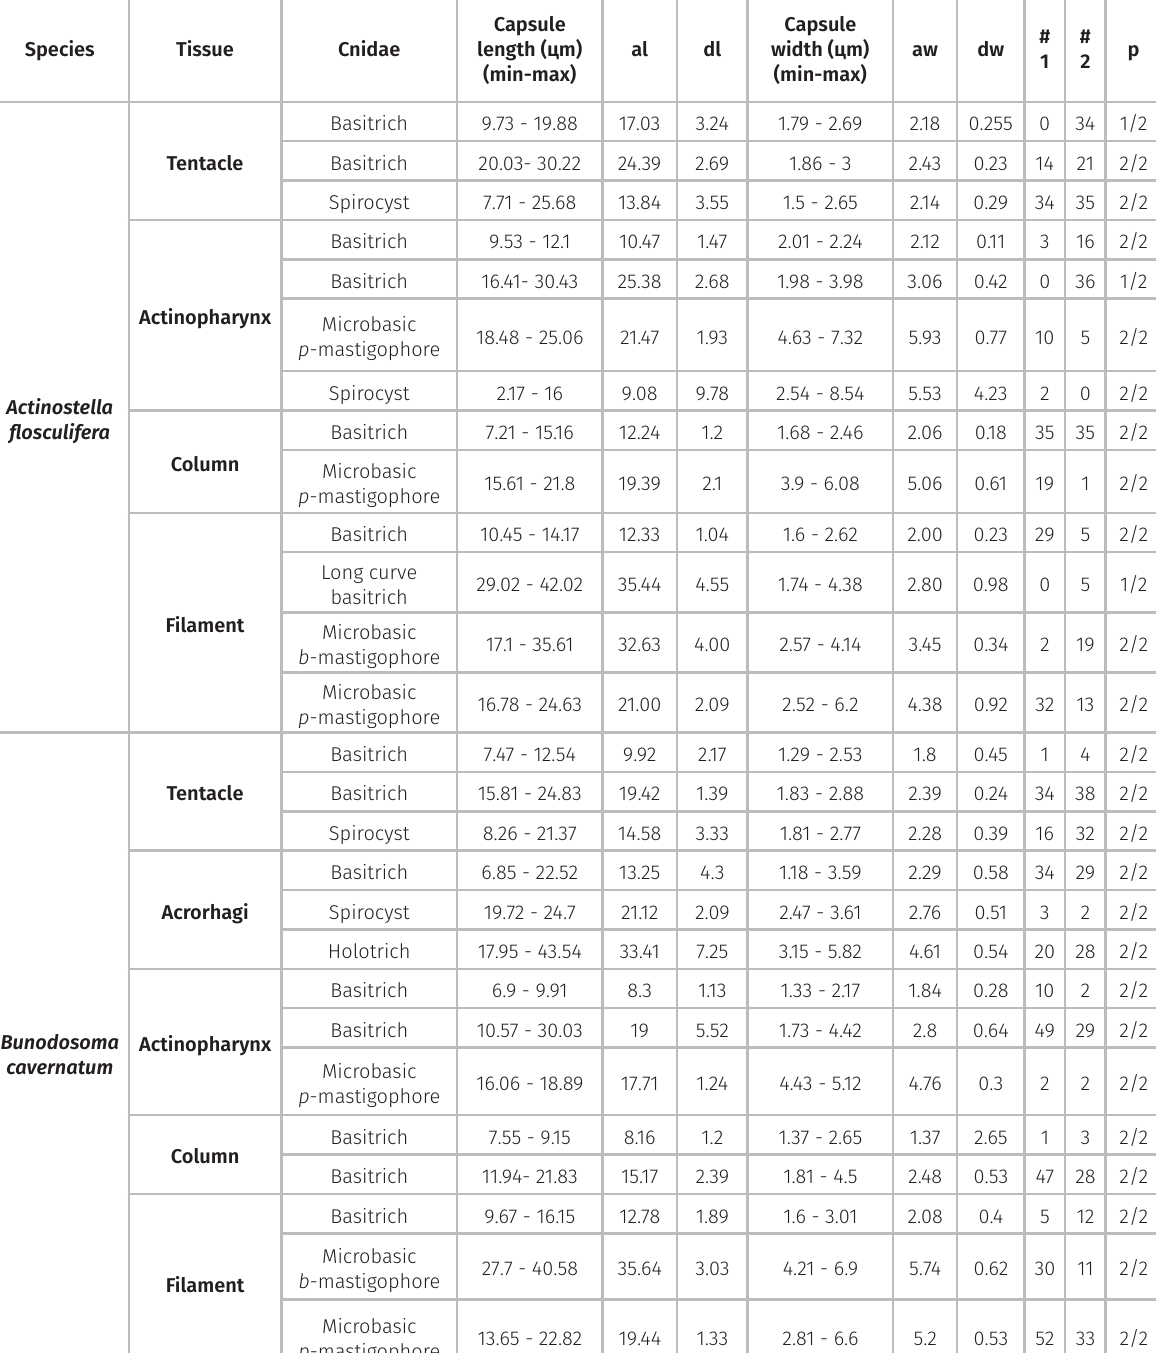
Table III. Size and distribution of cnidom in the sea anemones in the Atlántico Department. Abbreviation- al/ aw: average length/ average width; dl/dw: standard density/ standard width; #1 or #2: number of cnidocysts in specimen 1 or 2; p: